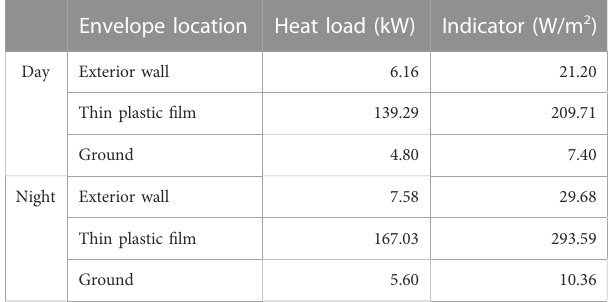
TABLE 2 Load distribution table of each envelope structure.